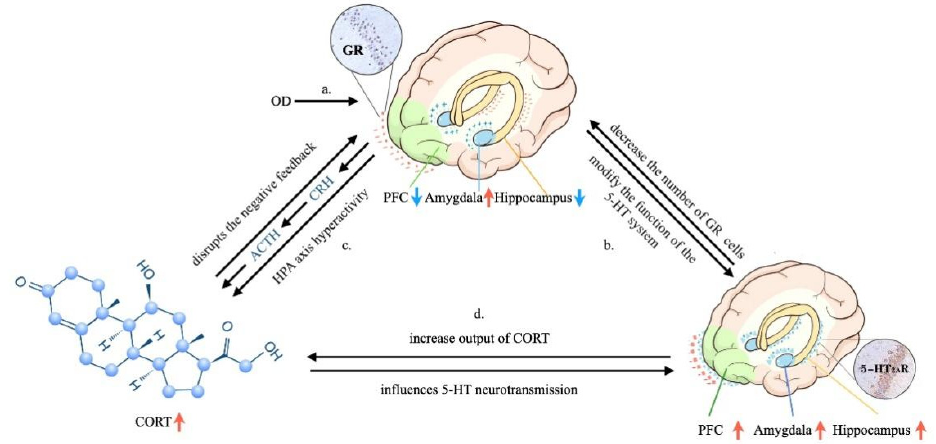
Figure 6. Possible mechanisms underlying the effects of OD. ( a ) OD may influence the regulation of emotion; ( b ) the relationship between the GR and 5-HT systems; ( c ) the relationships among GR, CORT and HPA axis; ( d ) the relationship between CORT and the 5-HT system. ↑ GR, 5-HT 2A R and CORT levels increased, ↓ GR level decreased